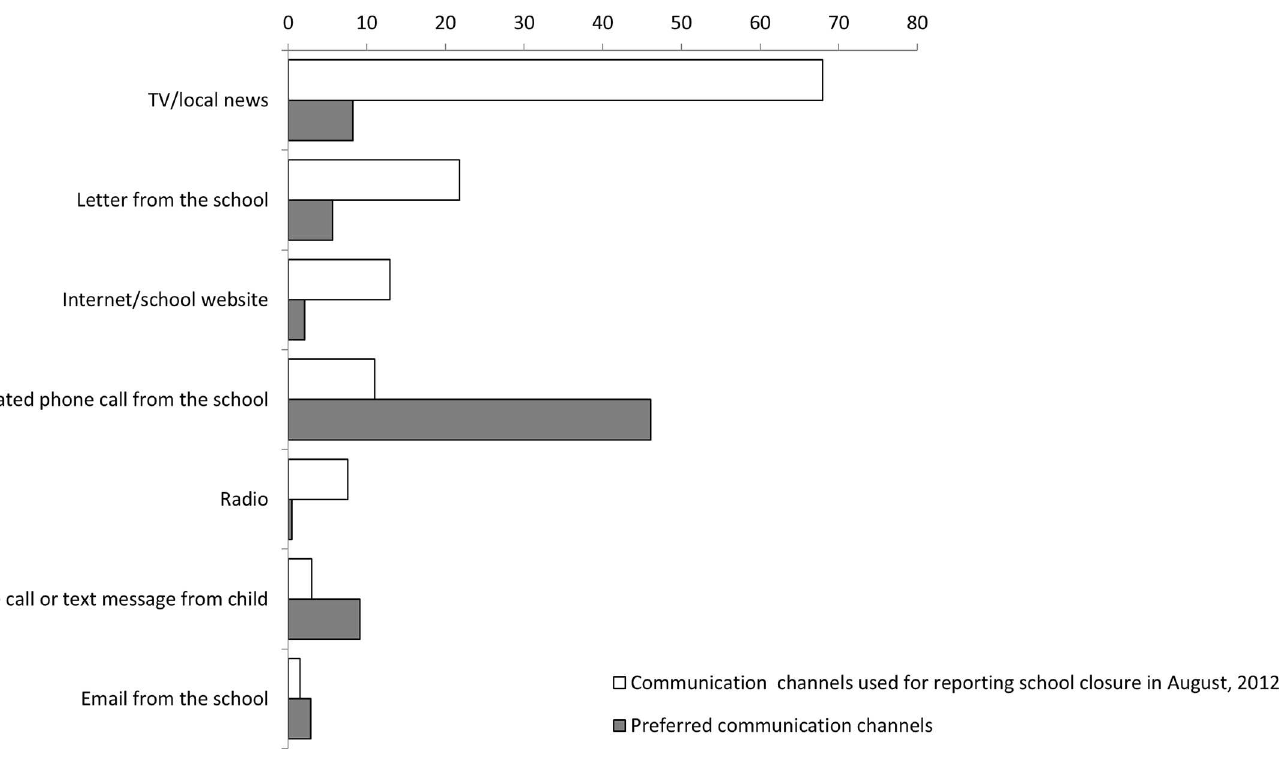
Fig 1. Communication of school closure information, Harrison County School District, Mississippi, August